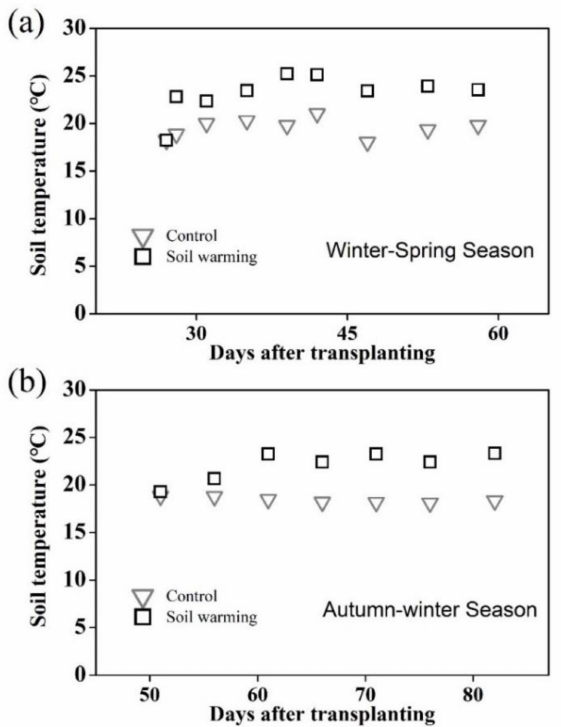
Figure 2. Soil temperature at a depth of 20 cm measured at 8:30–10:00 a.m. after soil warming in winter-spring season ( a ) and autumn-winter season ( b